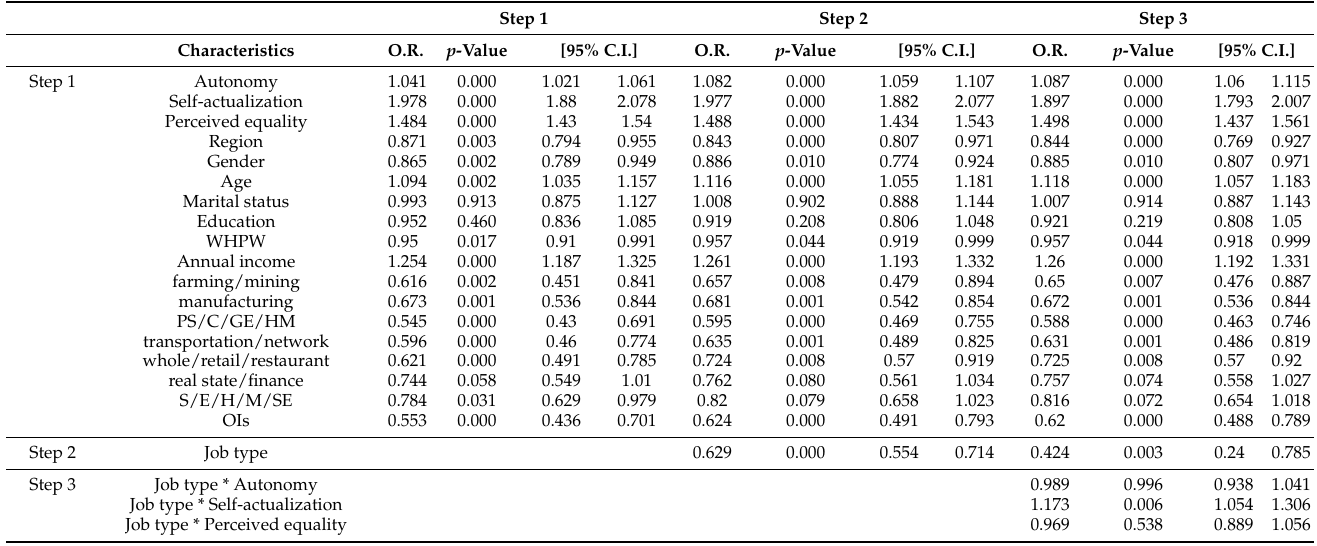
Table 4. Ordinal logistic regression of job satisfaction in full sample by